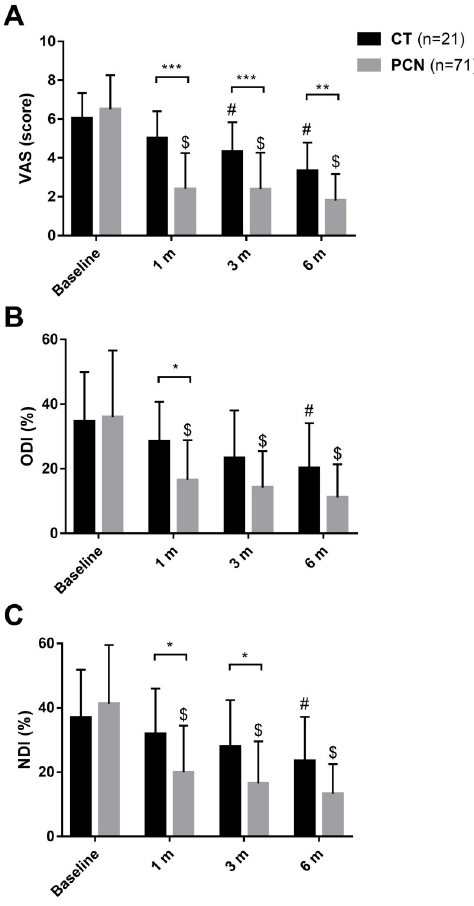
Fig 2. Six-month follow-up of pain scales and disability indexes. A chart showing the estimated VAS (A), ODI (B), and NDI (C) from the baseline record compared with those for the 6-month follow-up. � , �� , and ��� indicate between- group significance differences, with P -values < 0.05, < 0.01, and < 0.001, respectively. $ represents P < 0.01 compared with baseline value for the PCN group. # represents P < 0.05 compared with baseline value for the CT group. All data are presented as the mean ± SD. VAS: visual analog scale; ODI: Oswestry Disability Index; NDI: Neck Disability